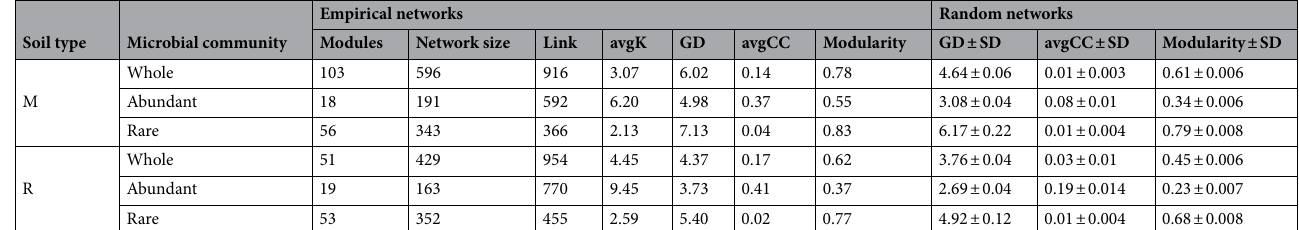
Table 4. Topological properties of the empirical molecular ecological networks (MENs) among whole, abundant and rare, and their associated random MENs in different cropping patterns of tobacco soil. Network size the number of OTUs (e.g., nodes) in a network, avgK average connectivity, GD average geodesic distance, avgCC average clustering coefficient, M tobacco monoculture, R tobacco-rice rotation, Whole whole bacterial communities, Abundant abundant taxa, Rare rare taxa.